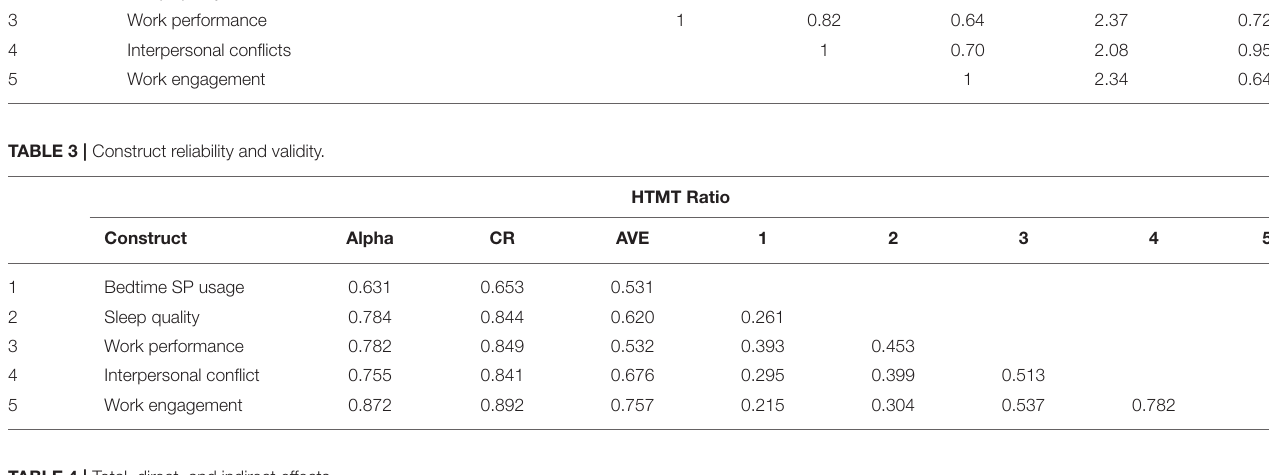
TABLE 4 | Total, direct, and indirect